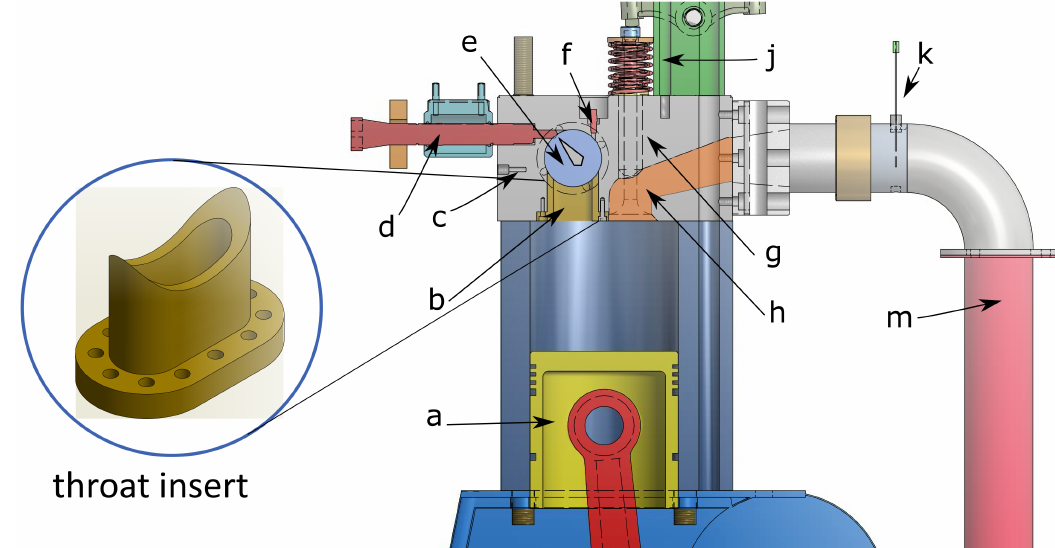
Figure 4. OACIC in place on top of single cylinder engine ( a ). Piston; ( b ). Connecting throat and insert; ( c ). Thermocouple; ( d ). Injector; ( e ). Optically accessible combustion region; ( f ). Pressure transducer; ( g ). Valves ( h ). Inlet and outlet; ( j ). Valve rocker arms; ( k ). Inlet pressure transducer and temperature thermocouple; ( m ). Inlet heater. Throat insert shown in